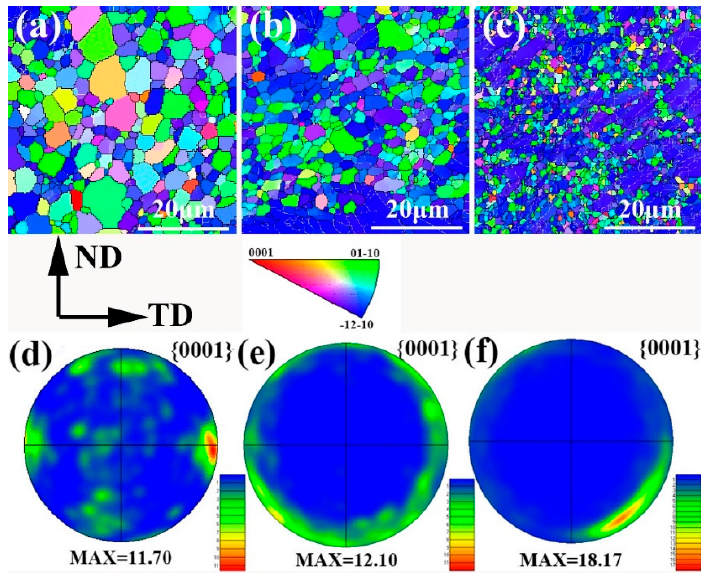
Figure 4. EBSD orientation maps and pole figures of as-extruded Mg-0.5Sr-xMn alloys : ( a , d ) x = 0 wt.% , ( b , e ) x = 1 wt.%, ( c , f ) x = 2 wt.%.